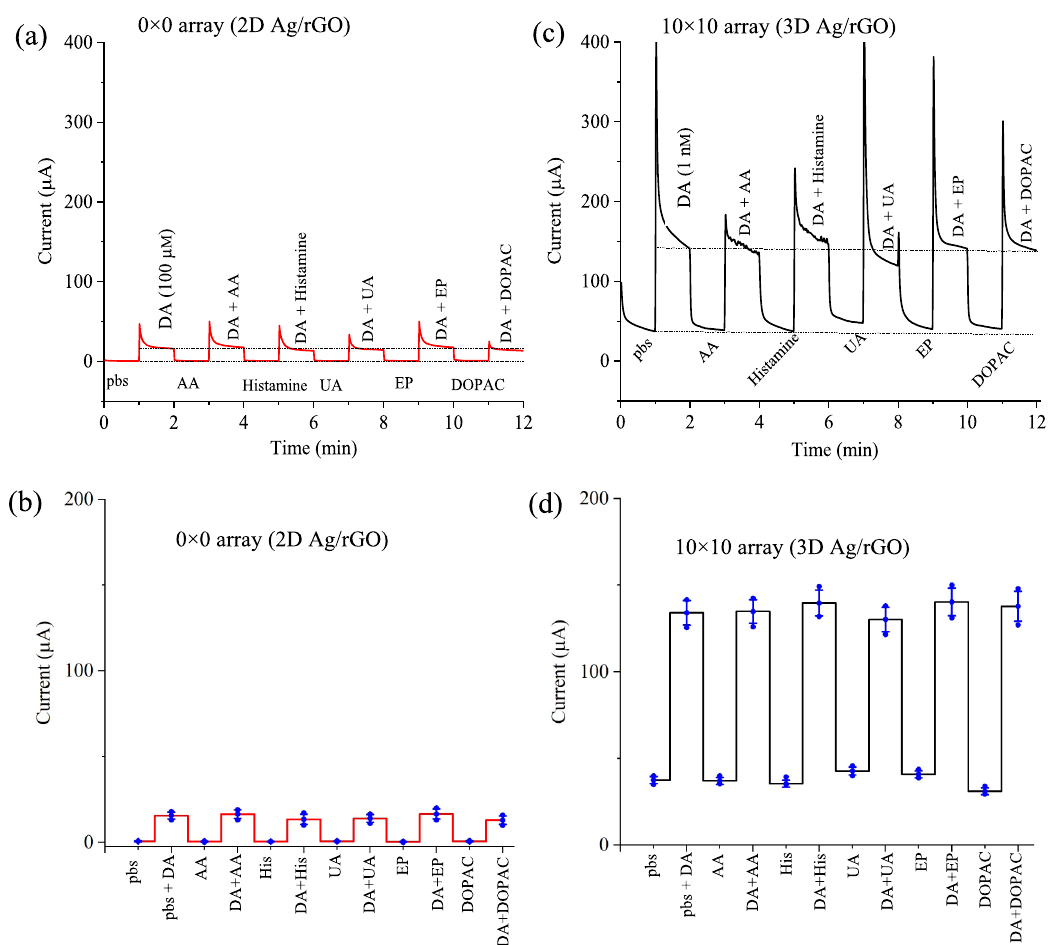
Fig. 7 Selectivity tests for dopamine sensors. Current as a function of time for ( a ) 2D Ag/rGO sensor and ( c ) 3D Ag/rGO sensor with and without dopamine by introducing a variety of interfering neurotransmitters such as ascorbic acid (AA), histamine (His), uric acid (UA), epinephrine (EP) and 3,4-Dihydroxyphenylacetic acid (DOPAC) at a potential of − 0.1 V. Current responses are plotted against interferents for 2D Ag/rGO ( b ) and 3D Ag/rGO ( d ). Error bars in ( b ) and ( d ) are the SD of measurements over at least n = 3 biologically independent experiments. Error bars, mean ±